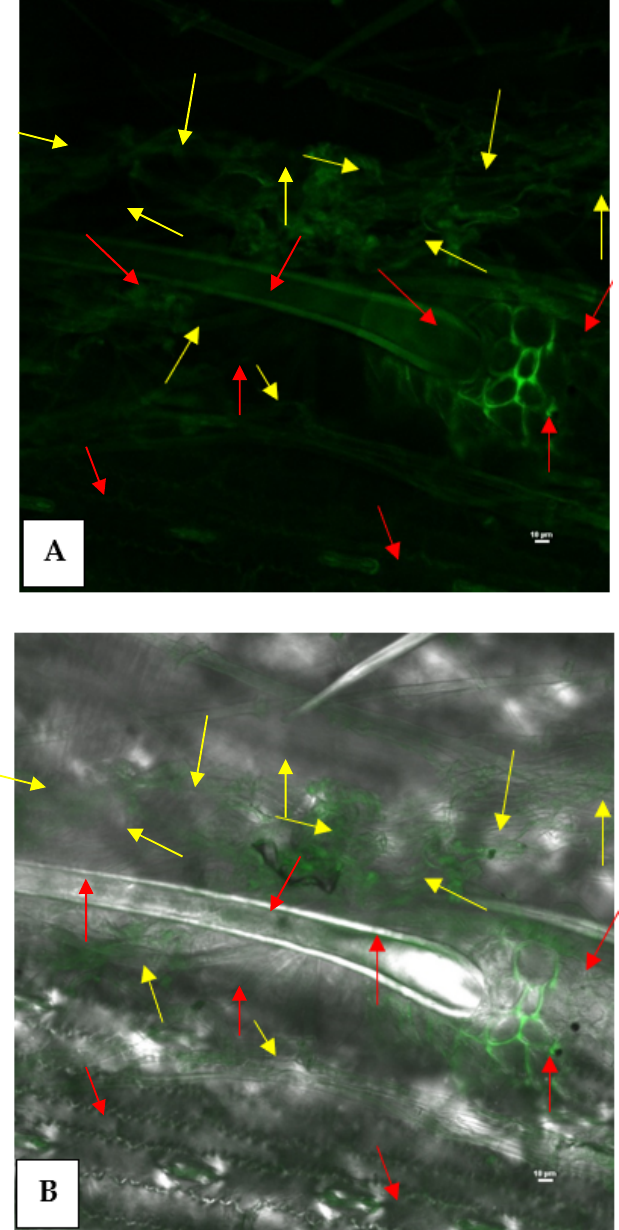
Figure 7. Confocal scanning laser microscopic image showing epiphytic colonization of GFP-tagged P. aeruginosa MF-30 on maize leaf. Red arrows indicate the colonization on different parts of the leaf, such as leaf surface, trichomes, basal cells of the trichome, stomata, etc., while yellow arrows show the colonization of P. aeruginosa MF-30 on fungal mycelia of R. solani and infection cushion developed on maize leaf. ( A ) Confocal micrograph at 488 nm channel and ( B ) confocal micrograph at 488 nm and TD channel together.